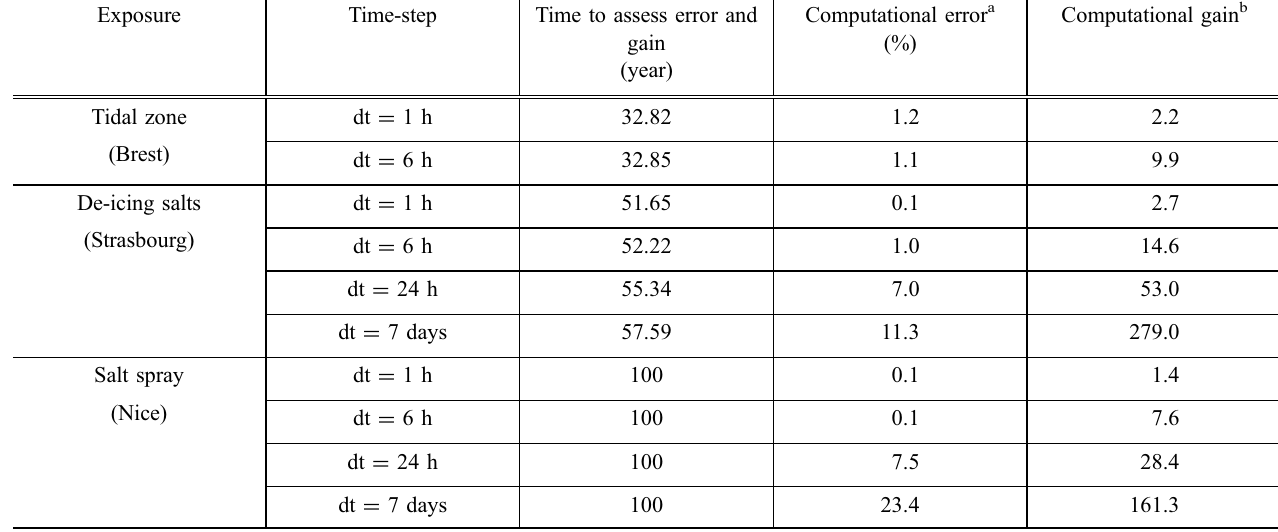
Table 3 Computational impact analysis for the reduced chloride ingress model.